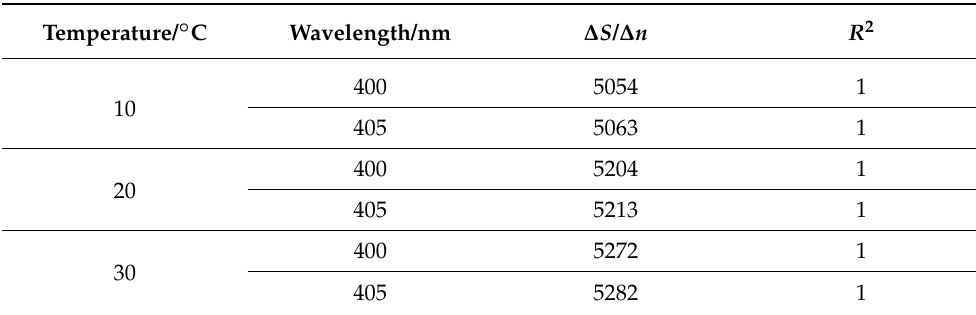
Table 3. The ratio of change of salinity ∆ S to change of refractive index ∆ n at different temperature- wavelength points.